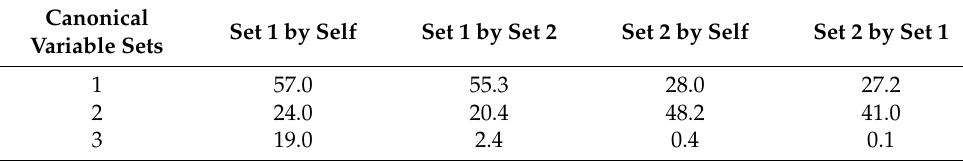
Table A6. Proportion (%) of variance